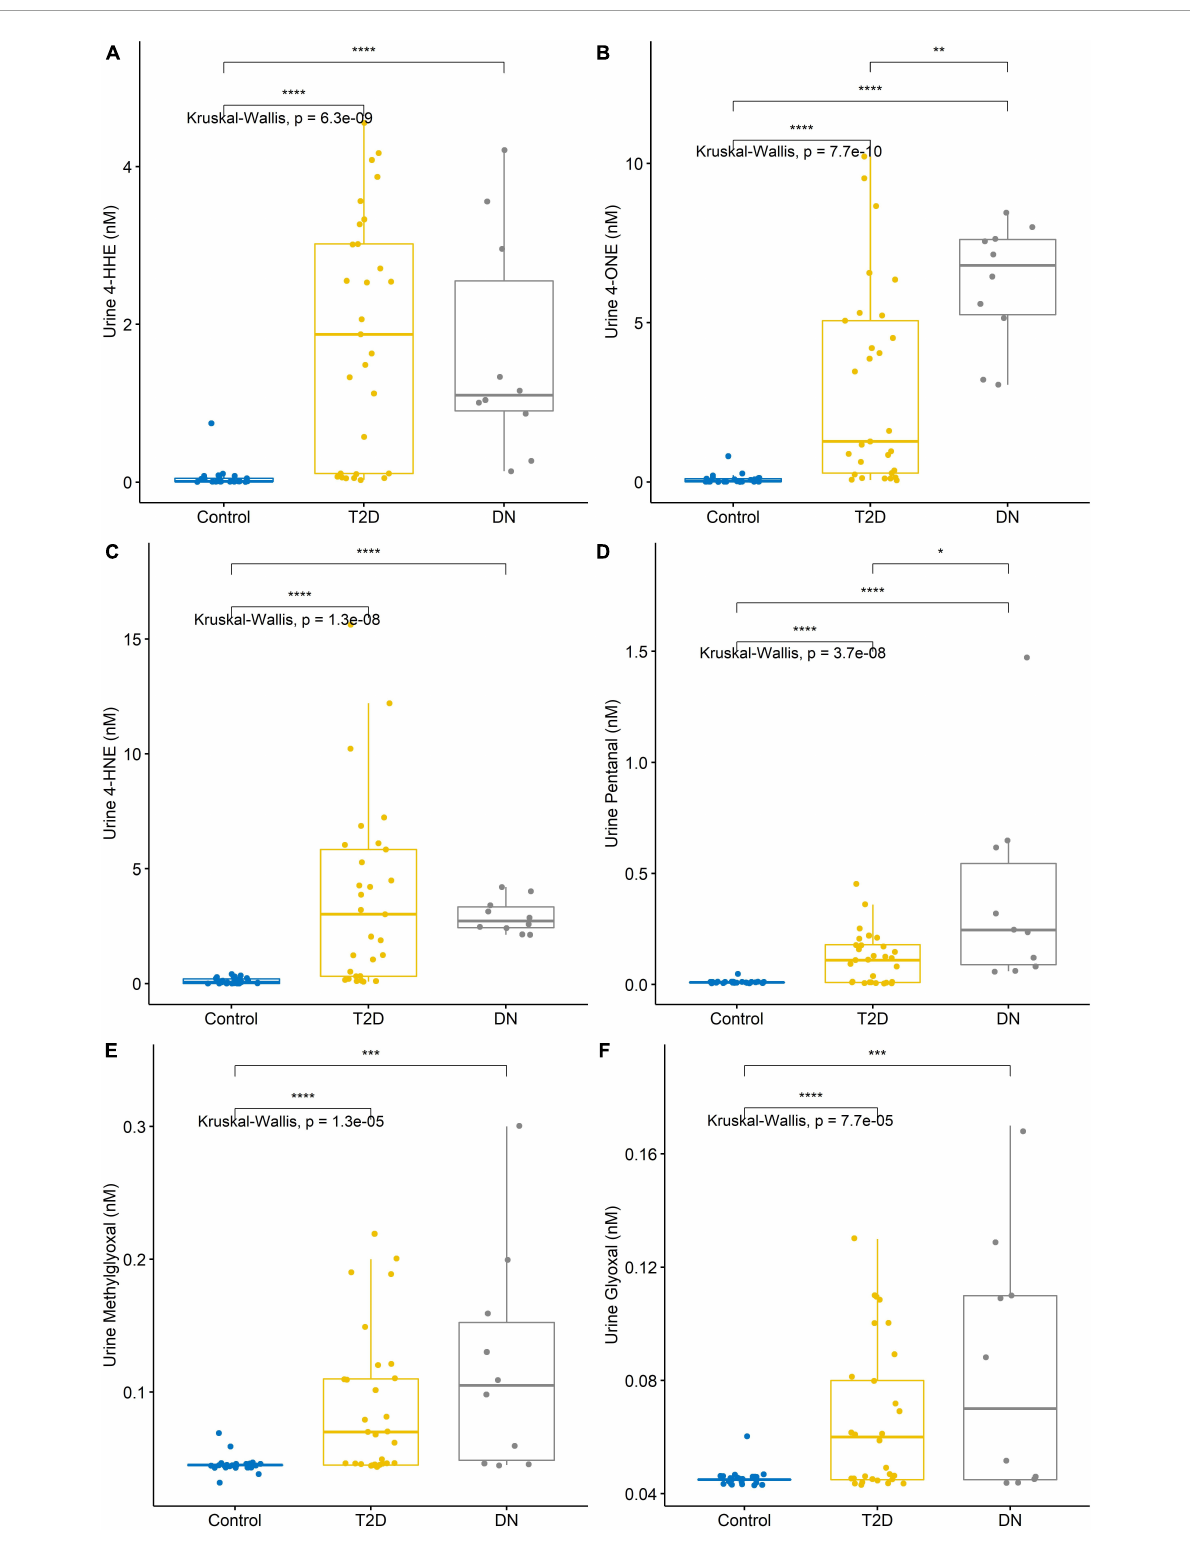
FIGURE2 Reactive aldehyde urine levels across control, type-2 diabetic mellitus (T2DM) and diabetic nephropathy (DN) groups (A) 4-hydroxynonenal (4-HHE), (B) 4-oxo-2-nonenal (4-ONE), (C) 4-hydroxyhexenal (4-HNE), (D) pentanal, (E) methylglyoxal, (F) glyoxal. Stars of significance * p < 0.05, ** p < 0.01, *** p < 0.001, and **** p <